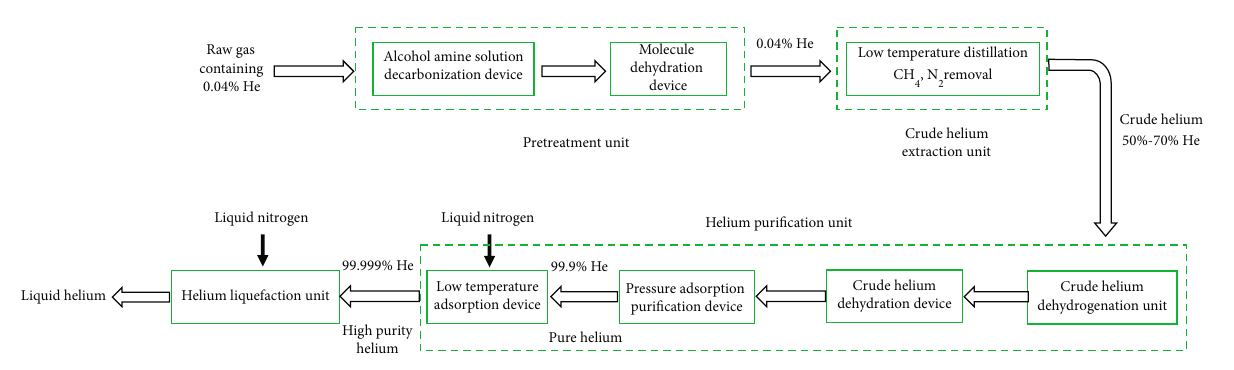
Figure 9: Flow of the deep cooling method.